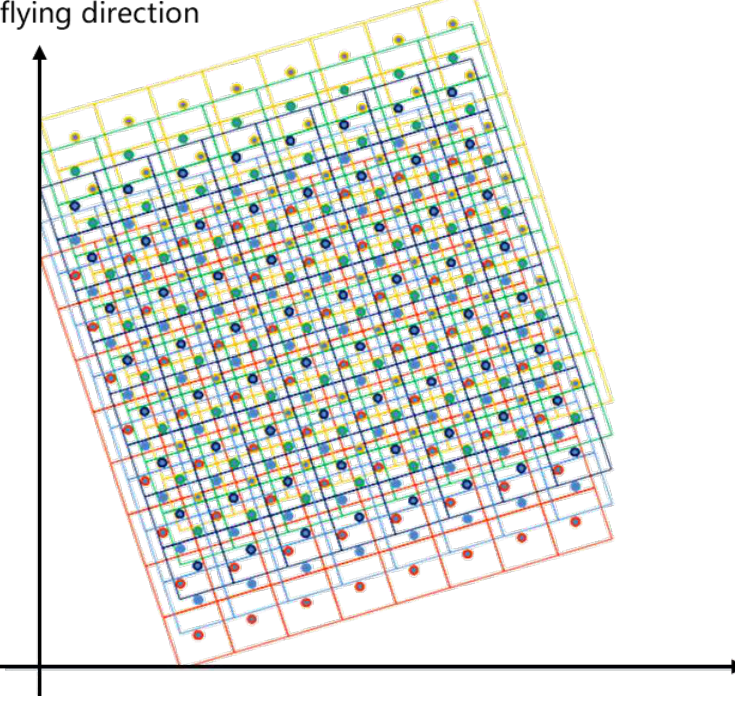
Figure 2. The diagram of oblique-mode sampling.